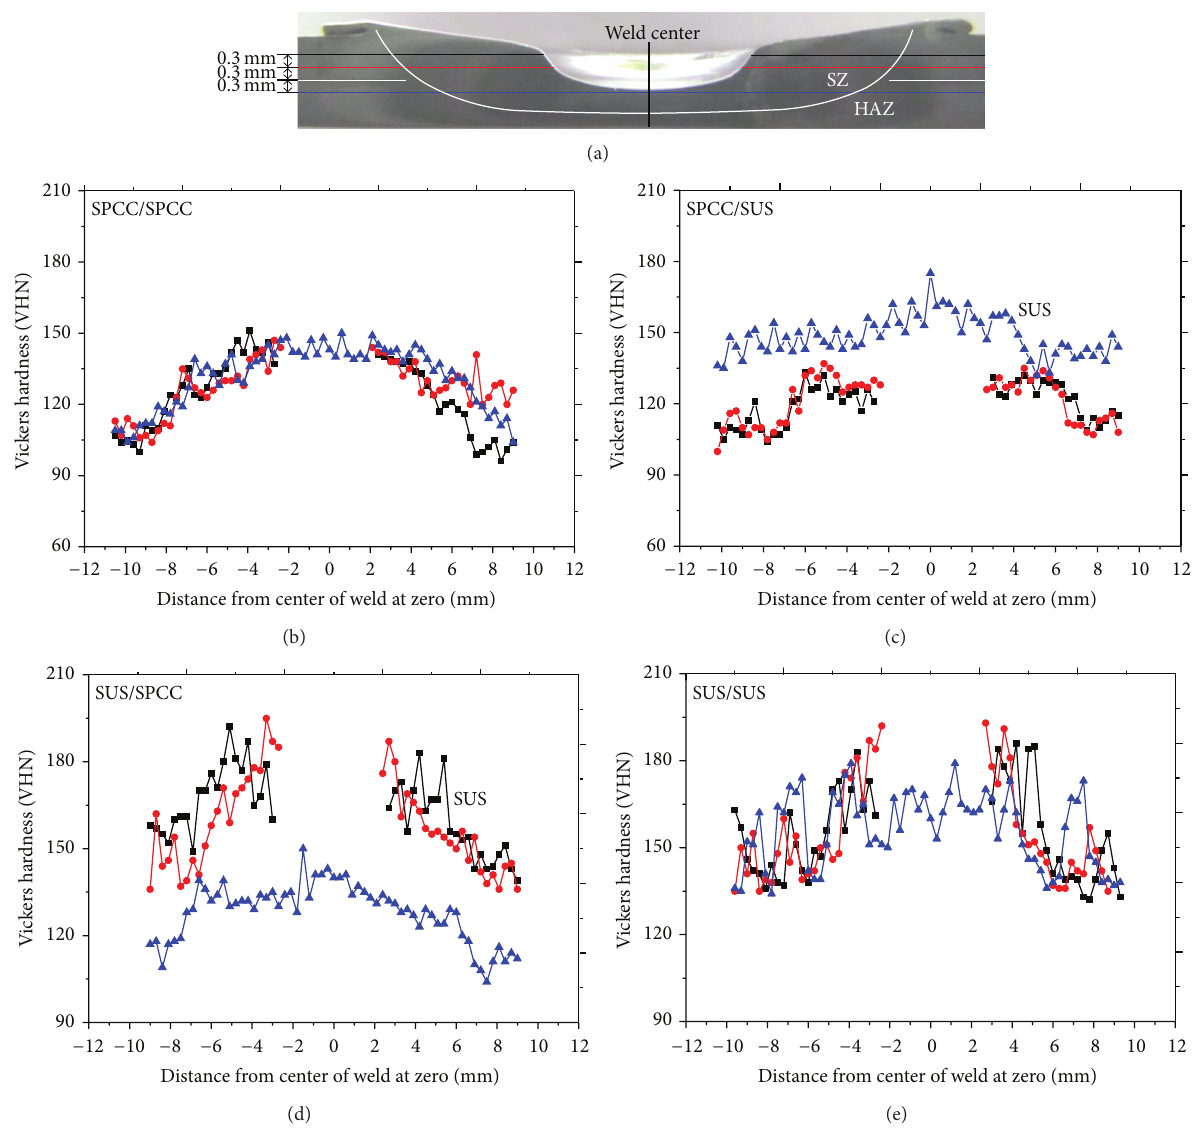
Figure 7: (a) Locations of the three parallel hardness traverses for a SPCC/SPCC joint; hardness profiles of FSSW joint cross sections, showing typical hardness distributions across the base metal, the HAZ, and the stir zone: (b) SPCC/SPCC, (c) SPCC/SUS, (d) SUS/SPCC, and (e)